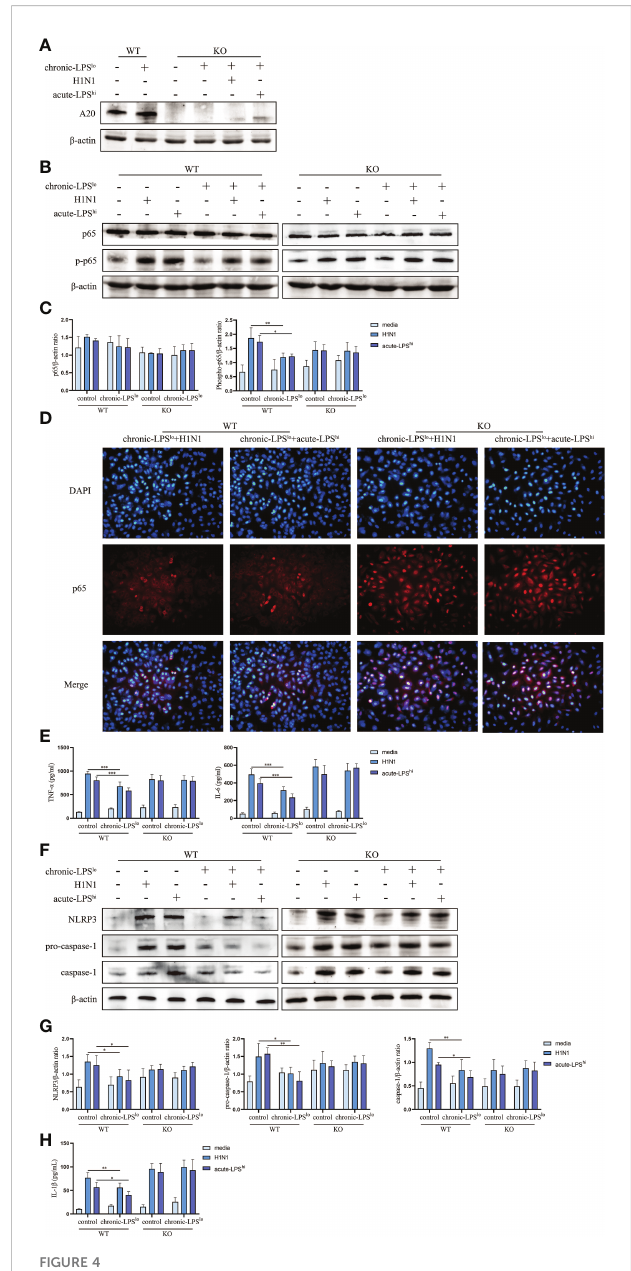
FIGURE 4 Effect of chronic low-dose LPS stimulation on NF- k B signaling pathway and NLRP3 in fl ammasome in high dose LPS-stimulated or H1N1-infected A549 WT and A549 A20-KO cells. (A) Relative protein levels of A20 in A549 A20-KO cells were detected by western blot. (B, C) Relative protein levels of p65 and p-p65 in A549 WT cells and A549 A20- KO cells were detected by western blot. (D) Immuno fl uorescent images of the localization of p65 in A549 WT and A549 A20-KO cells. (E) TNF- a and IL-6 in A549 WT and A549 A20-KO cells culture supernatants were measured by ELISA. (F, G) Relative protein levels of NLRP3, pro- caspase-1 and caspase-1 in A549 WT and A549 A20-KO cells were detected by western blot. (H) IL-1 b in A549 WT and A549 A20-KO cells culture supernatants were measured by ELISA. Data are mean ± SD, n = 3. *p< 0.05, **p<